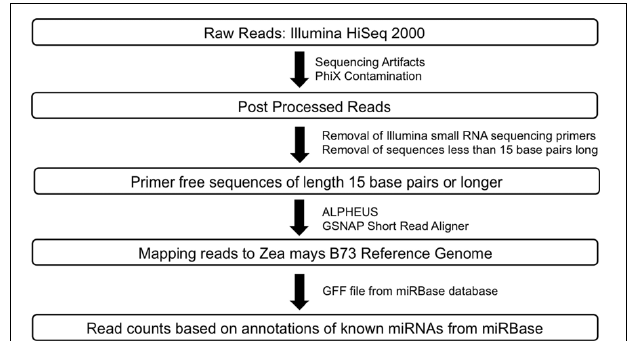
FIGURE 3 | Workflow for smRNA sequence data